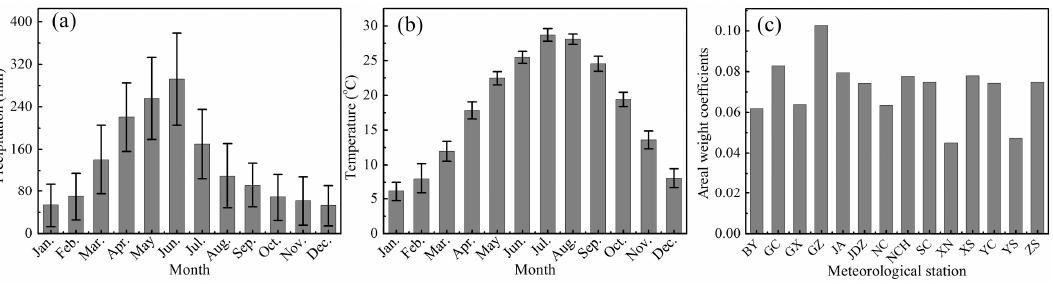
Figure 2. Mean monthly precipitation ( a ); and temperature ( b ); and the areal weight coefficients from Thiessen method for the 14 meteorological stations ( c ) in the Poyang Lake Basin from 1961 to 2012.